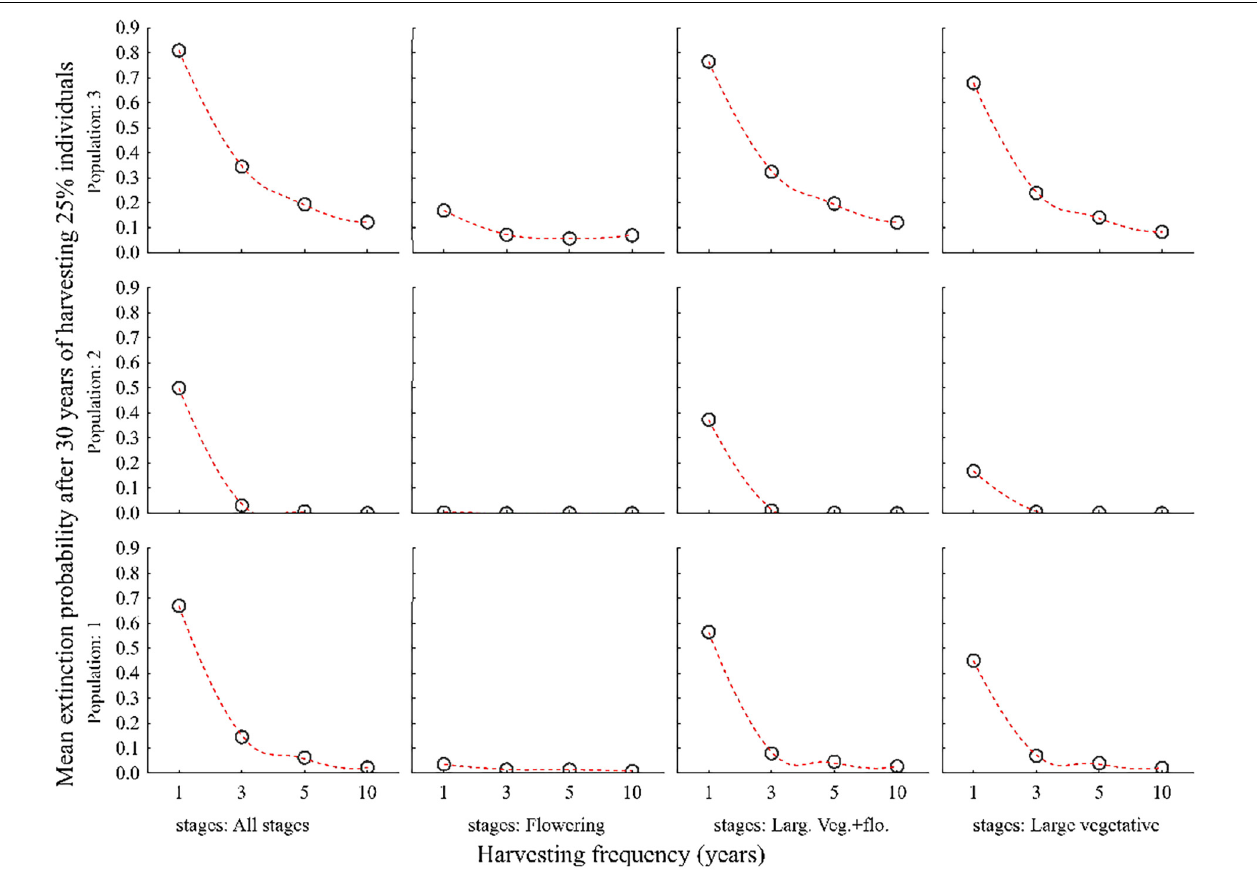
FIGURE 5 | Probabilities of three populations of C. acuminatum becoming extinct in 30 years when 25% of the individuals in all stages, only the large vegetative and flowering stages (Large veg. and flow.), only the large vegetative stage (Large vegetative) or only the flowering (Flowering) stage are harvested at different frequencies. 1, 3, 5, 10 on X -axis indicates the interval of harvesting in